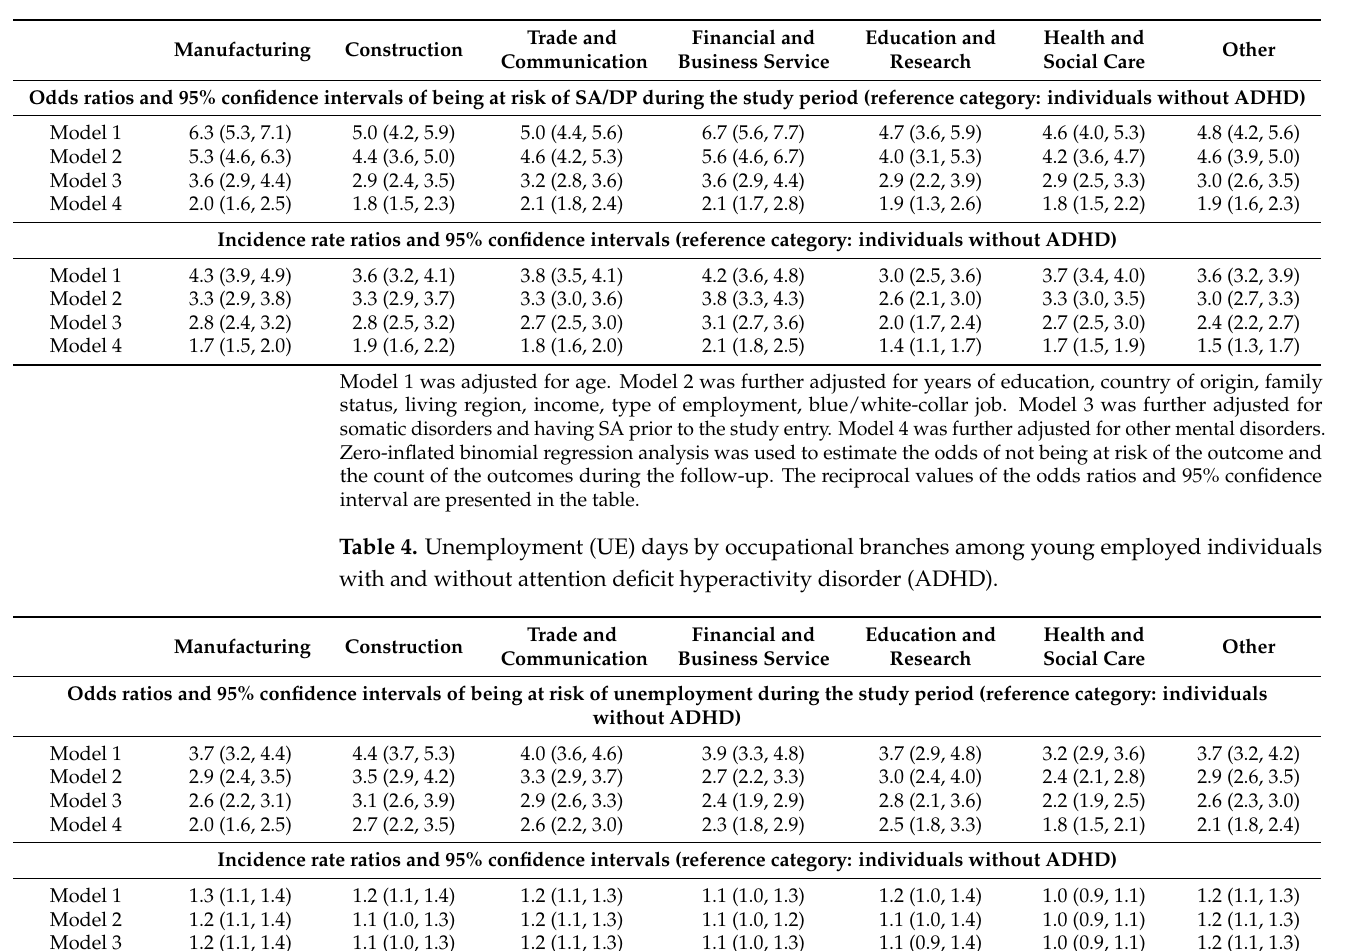
Table 3. Sickness absence and disability pension (SA/DP) days by occupational branches among young employed individuals with and without attention deficit hyperactivity disorder (ADHD).